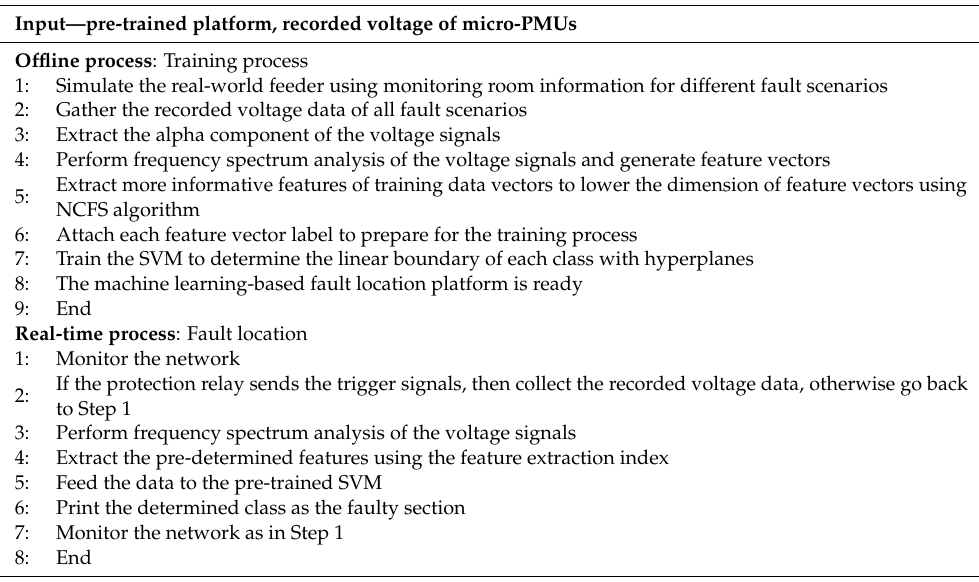
Algorithm 1. Machine Learning-Based Fault Location